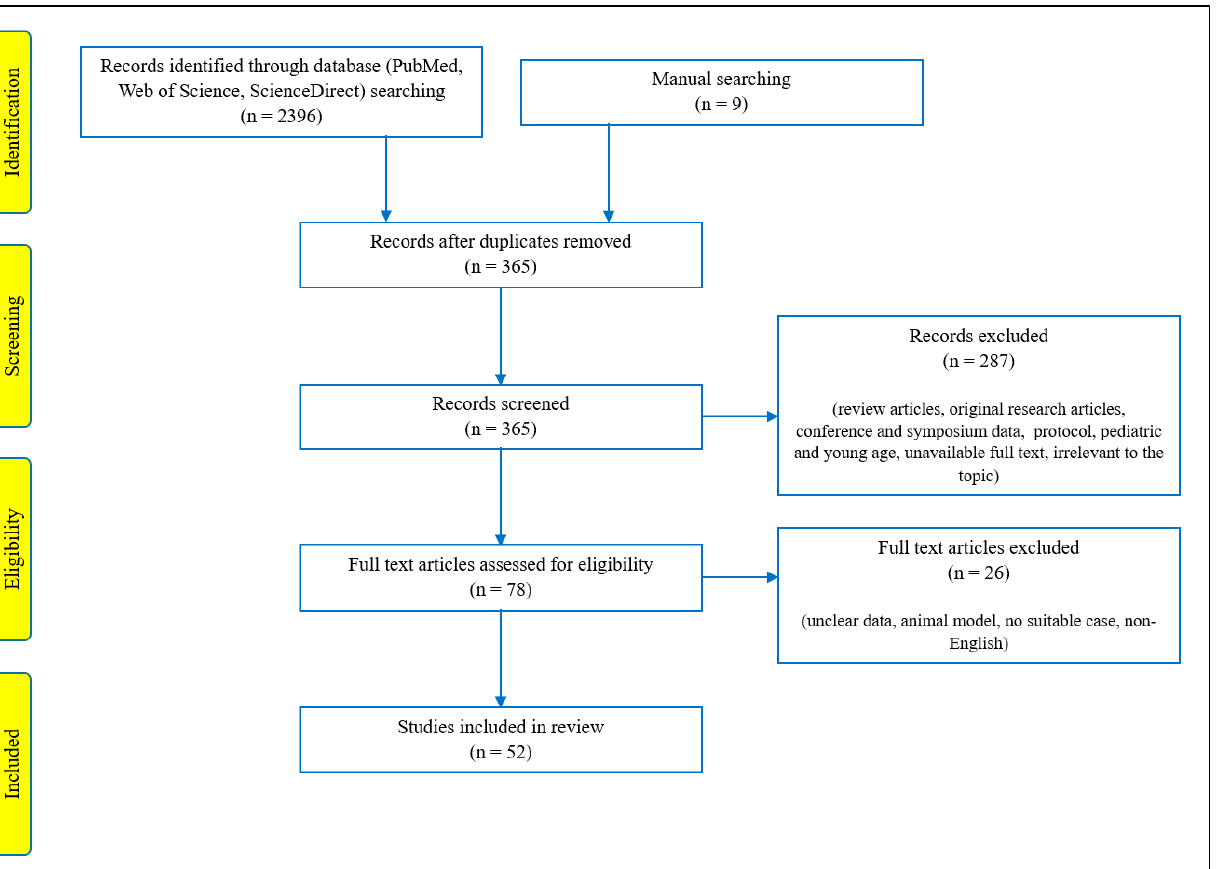
Figure 1. PRISMA flow diagram of search procedure .